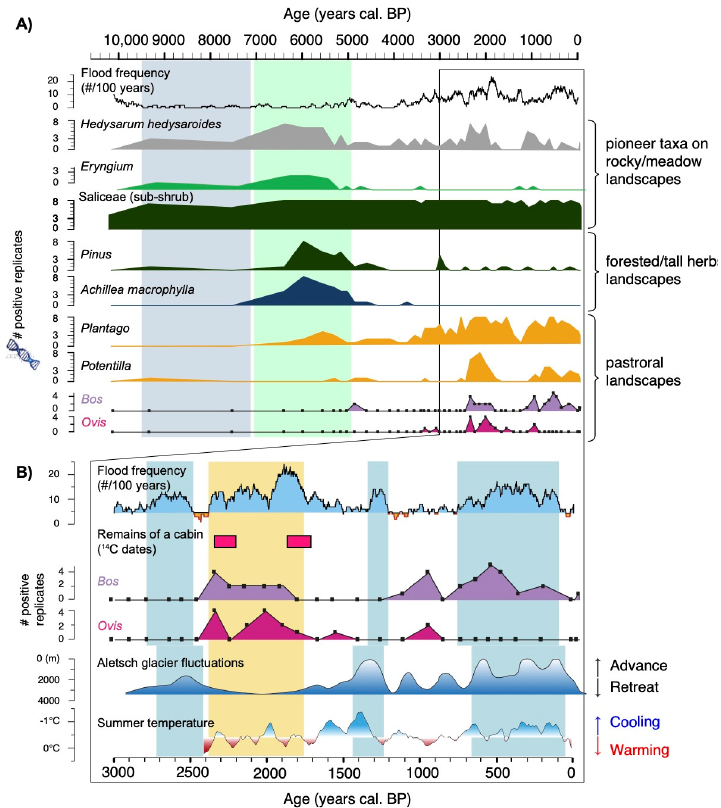
Figure 11. ( A ) Flood frequency recorded in Lake Anterne (European Alps) compared with the landscape changes reconstructed from a selection of plant taxa and mammals detected by DNA analyses over the last 10,000 years (modified after Pansu et al., 2015 [159]). The phases in blue and green represent, respectively, the developments of pioneer taxa on rocky/meadow environments and then of the open forest landscape with tall herbs growing on well-developed soils. ( B ) Focus on the last 3000 years to highlight periods of high flood frequency in phase with periods of high pastoral activities (based on mammal DNA analyses and 14C dates performed on charcoals from remains of a pastoral cabin discovered close to the lake) and/or climatic changes (highlighted by the reconstructions of Aletsch Glacier fluctuations [160] and summer temperature from tree-rings 169 ) (modified after Giguet-Covex et al., 2014 [161]). The blue-colored areas represent periods of high flood frequency associated with periods of glacier advances and cold (and/or wet) conditions. The orange- colored area represents the period of high flood frequency associated with a period of glacier retreat and warm (and/or dry) conditions, but high pastoral activities. All DNA analyses are represented in a number of positive replicates (i.e., when more than 5 DNA sequences were detected in a sample replicate). Eight sample replicates were performed in